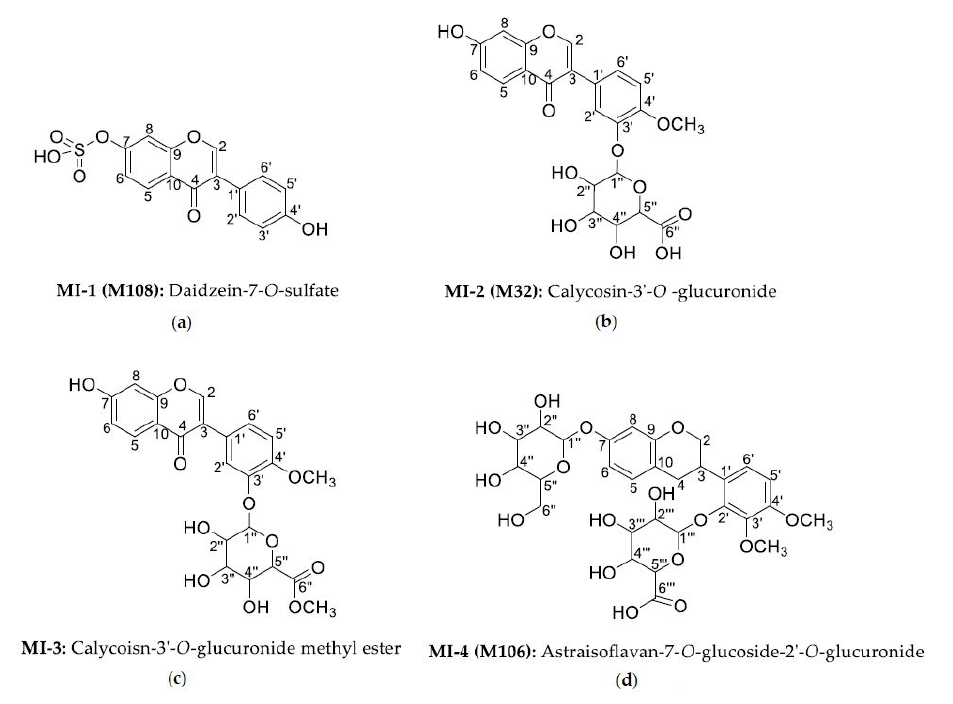
Figure 3. The structures of isolated metabolites from drug-containing urine. ( a ) MI-1 ( M108) ; ( b ) MI-2 ( M32) ; ( c ) MI-3 ; ( d ) MI-4 ( M106)